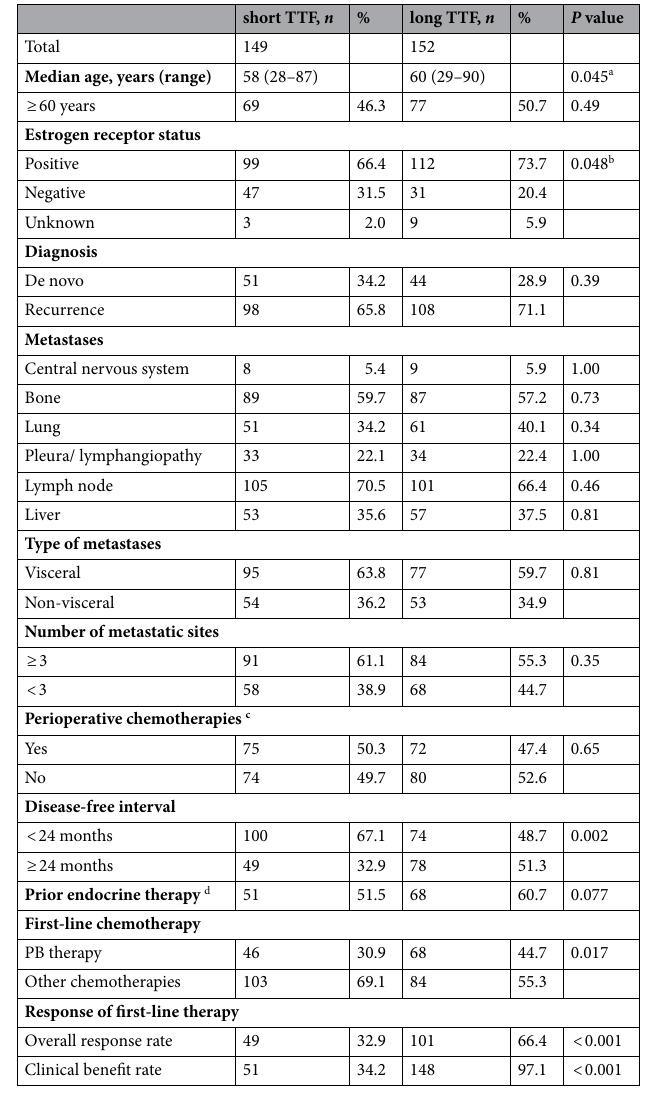
Table 1. Patient characteristics at baseline. PB paclitaxel plus bevacizumab, TTF time to treatment failure. a Wilcoxon’s rank-sum test was performed. b Comparing estrogen receptor positive and estrogen receptor negative. c Treatment included anthracycline and/or taxane. d Endocrine therapy for advanced breast cancer treatment before first-line chemotherapy in patients with estrogen receptor